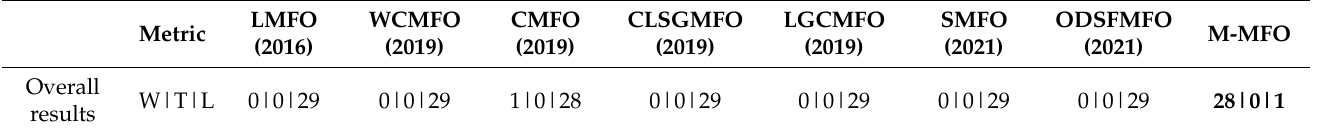
Table 2. The overall results of MFO variants for dimension 30.